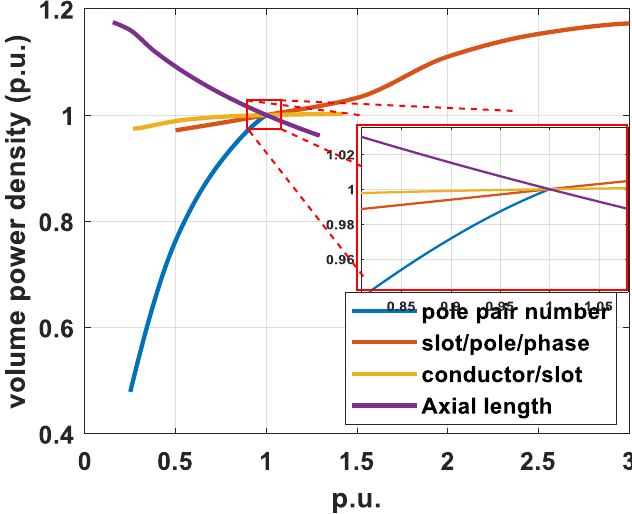
Figure 8. Effect of the input parameters on the volume power density.